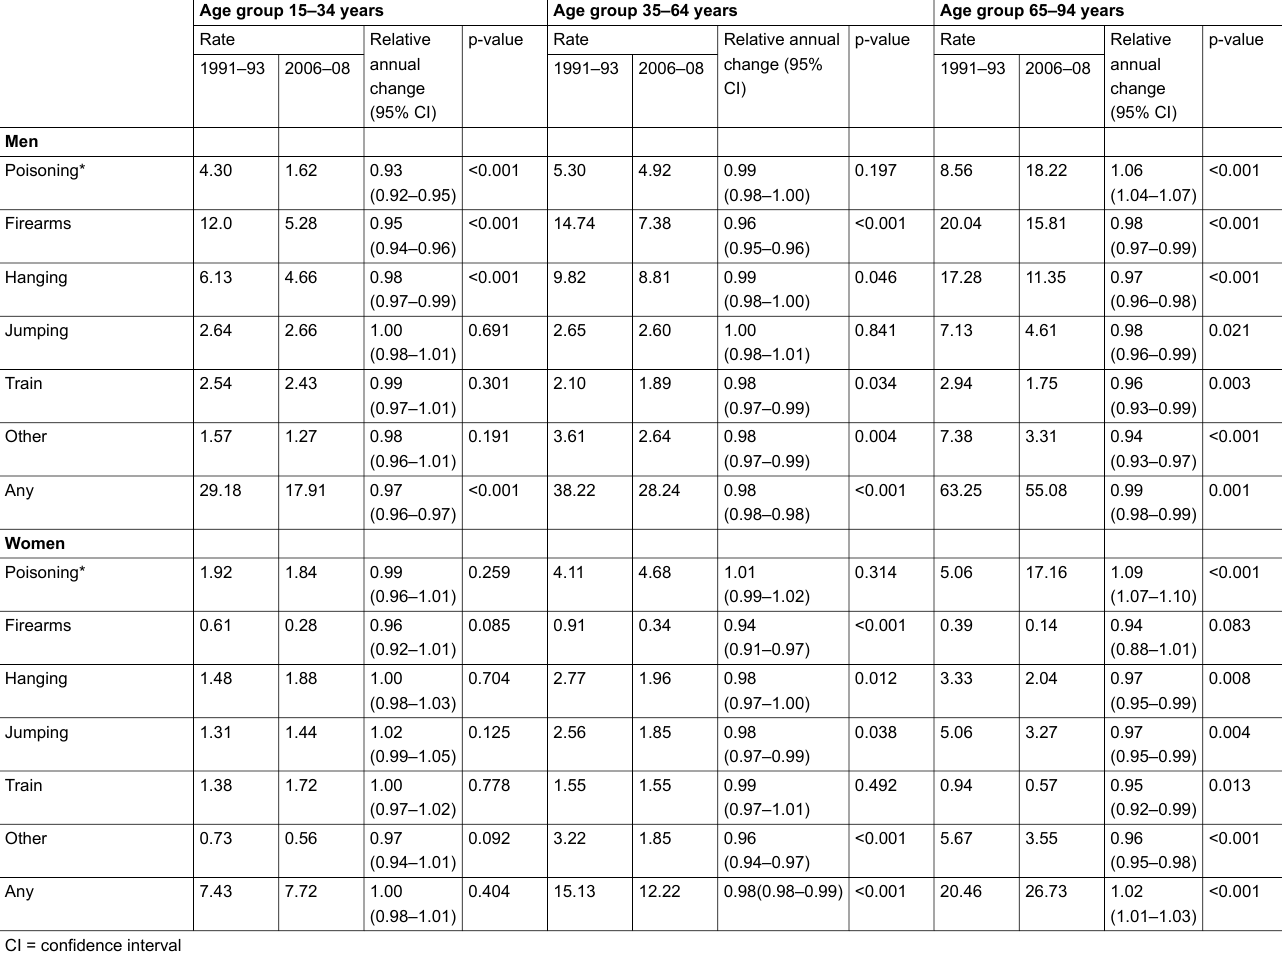
Table 2: Rates of suicide per 100'000 person-years by different methods in the first time period (1991–1993), in the last time period (2006–2008); the relative annual change and the p-value for time trend (from Poisson regression) by age group and